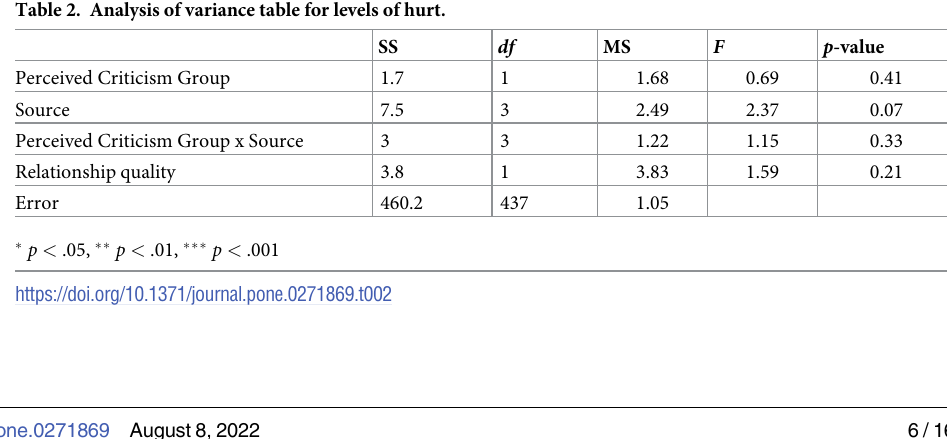
SS df MS F p -value 3.8